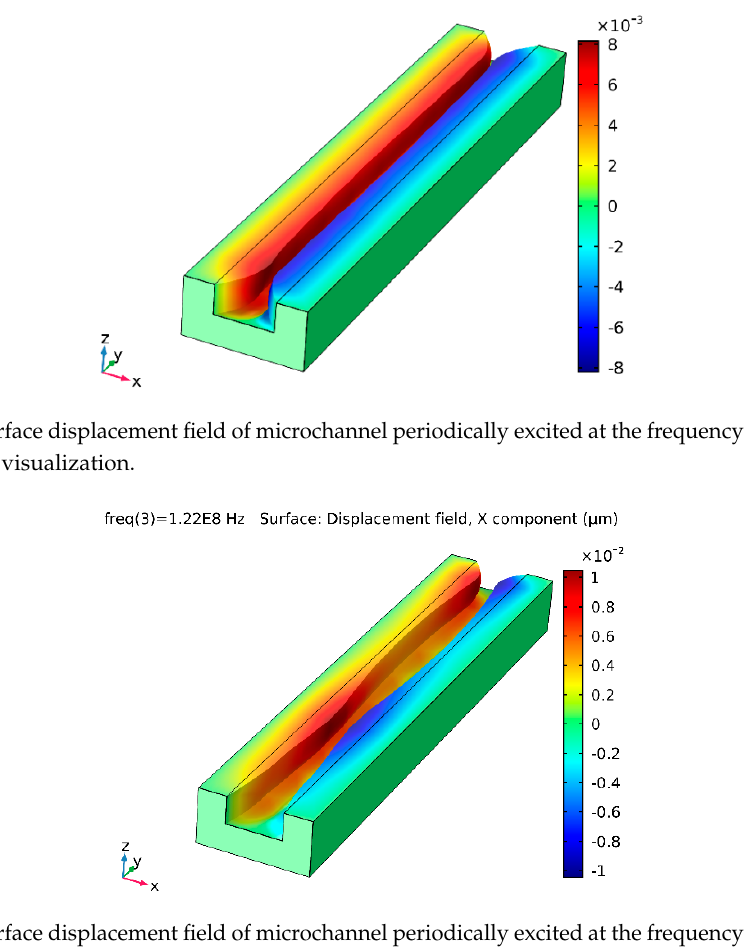
Figure 17. Surface displacement field of microchannel periodically excited at the frequency of 122 MHz: X component visualization.